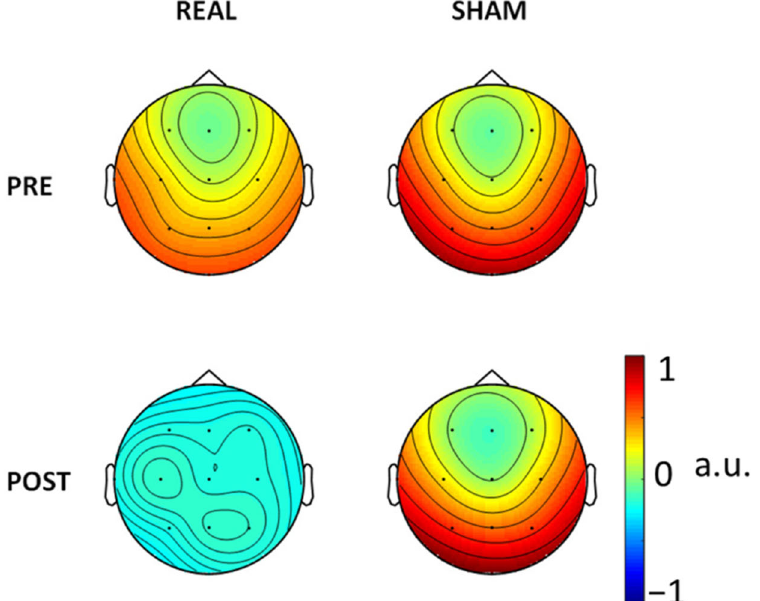
Figure 3. FS_Epi topographical representation (arbitrary units, a.u.) via the weights on the recording channel positions resulting from the constraint applied in the four conditions.